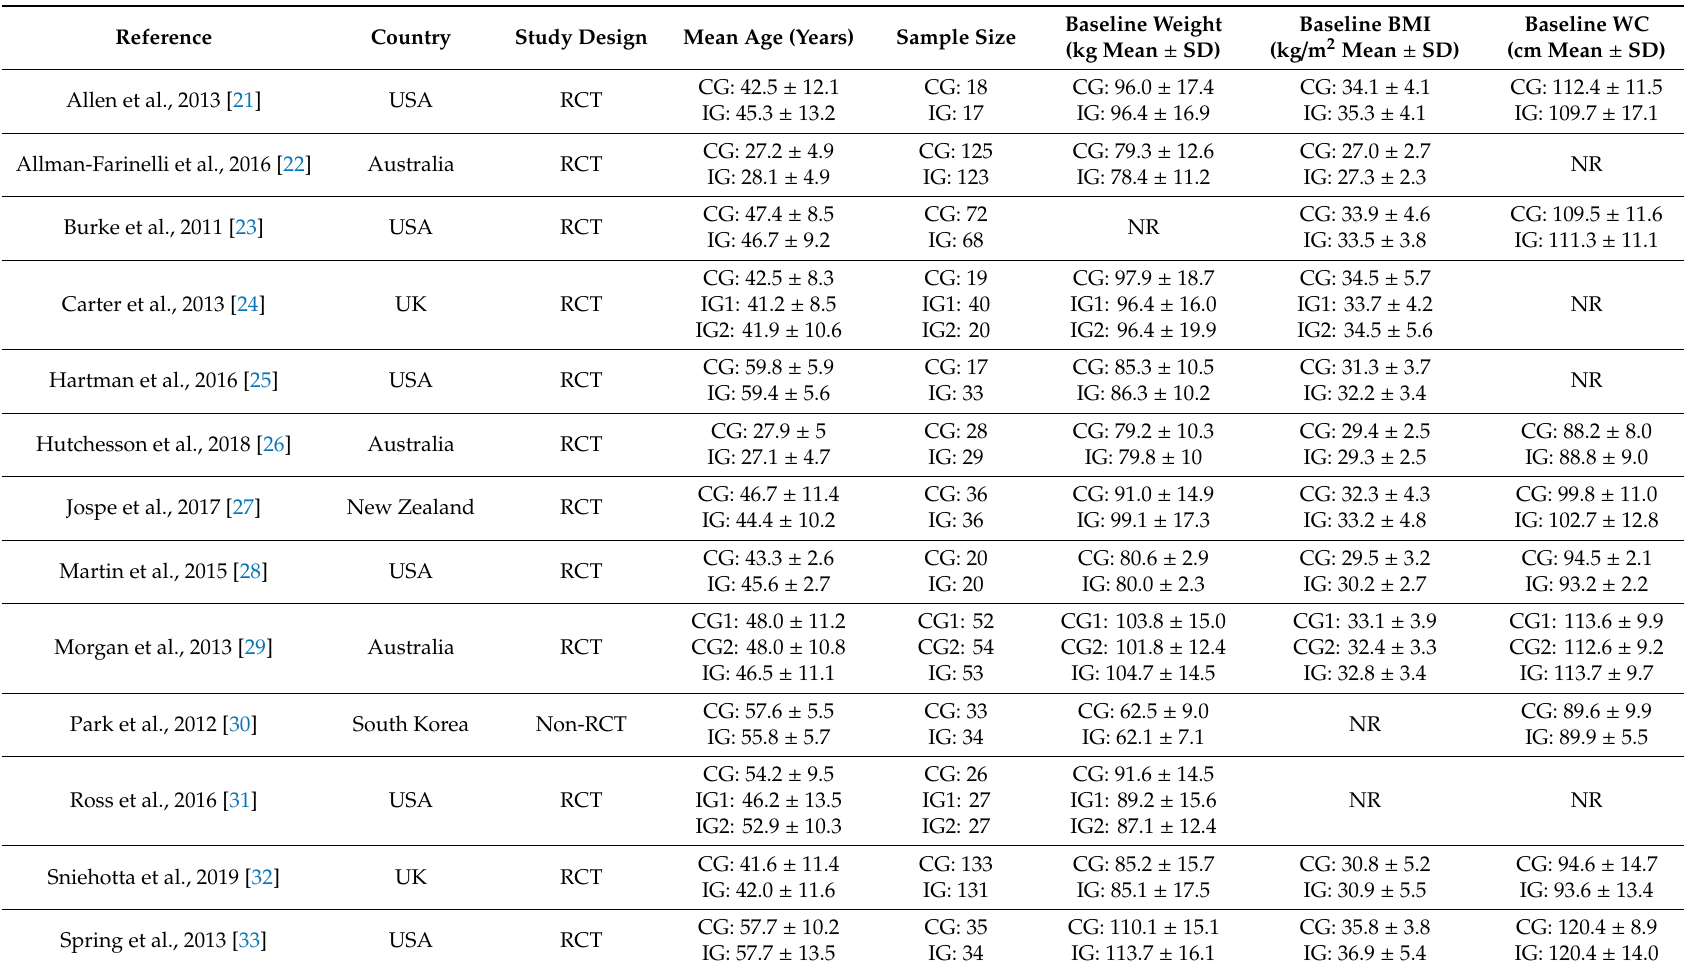
Table 1. Characteristics of studies included in the